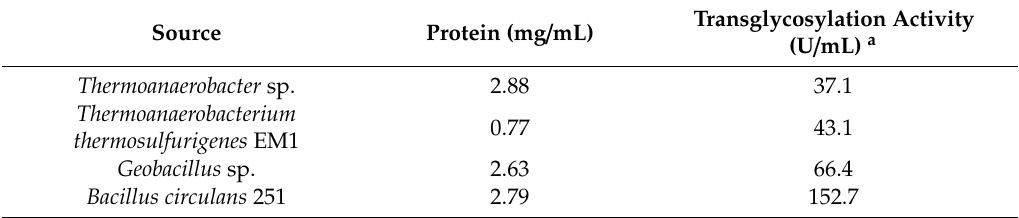
Figure 1. HPLC chromatogram of the reaction mix after 24 h displaying the acceptor products of tert -butyl alcohol synthesized with CGTases from Thermoanaerobacter sp. and Thermoanaerobacterium thermosulfurigenes EM1. Reaction conditions: Soluble starch (30 g/L), 30% tert -butyl alcohol, 10 mM sodium citrate buffer (pH 5.5), CGTase (0.4 U/mL, EPS method), and 60 °C. (1) Main glucosylation product; (2) minor glucosylation product; and (3) glucose. Table 1. Cyclodextrin glucanotransferases (CGTases) screened for the glucosylation of tert -butyl